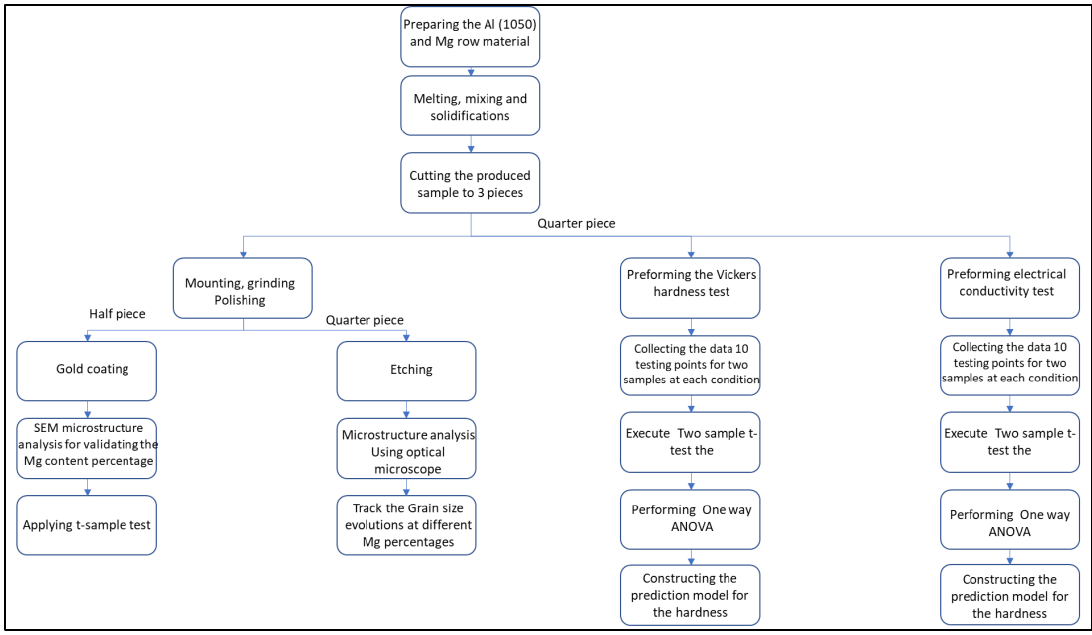
Figure 1. Case study flowchart.